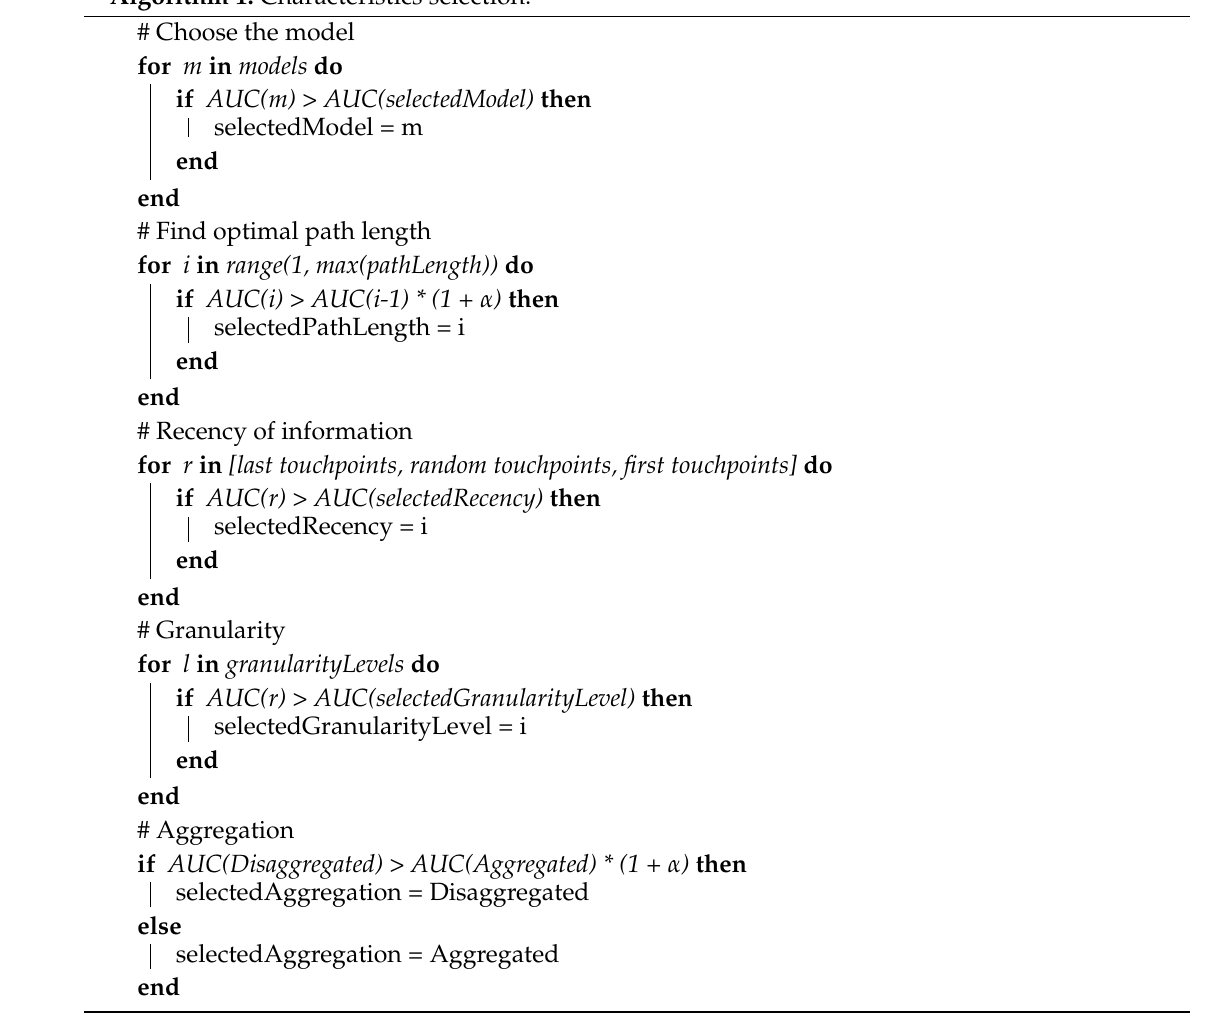
Algorithm 1: Characteristics